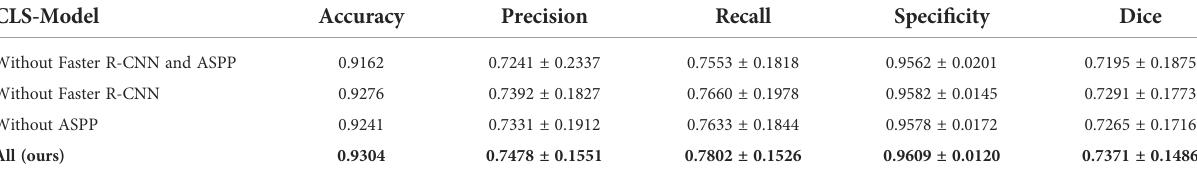
TABLE 3 Ablation experiments on the improved Faster R-CNN and